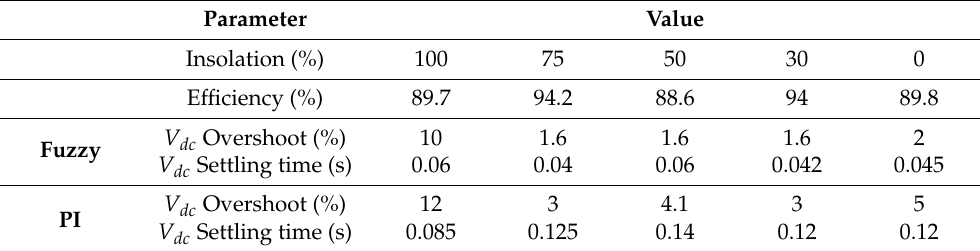
Table 3 summarizes the comparison of the two controllers. The system efficiency was calculated against the solar insolation level for the fuzzy and PI controllers. The efficiency value was not affected by the controller type. Table 3. Summary of the